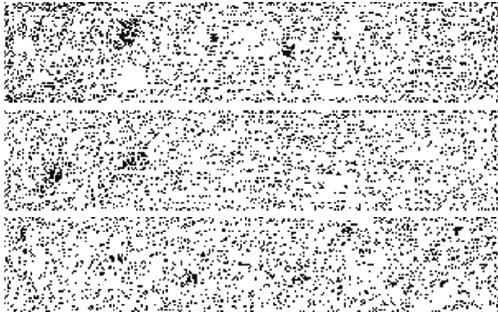
Figure 6: Three samples of masks used for choosing consistent bits in iris codes. Two upper masks are related to two subjects in CASIA-IrisV3, and the last one corresponds to a subject in Bath iris